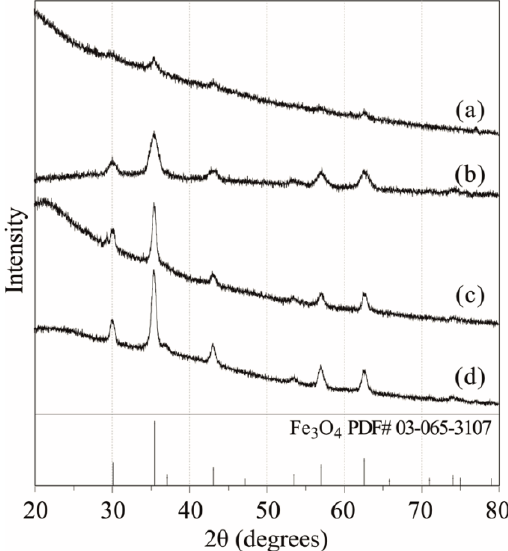
O nanoparticles. 3 4